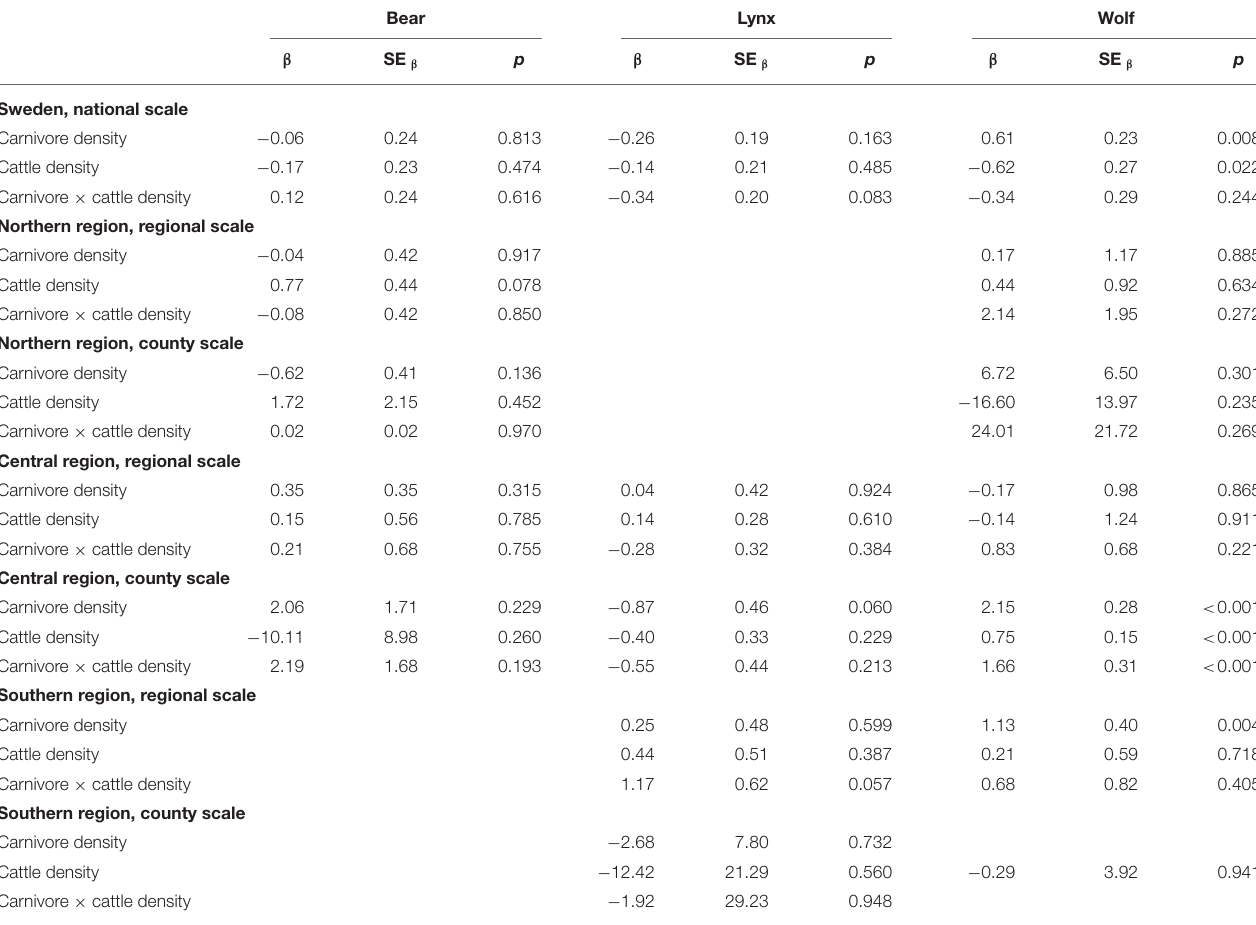
TABLE 1 | Beta coefficients describing the relationships between number of damaged cattle by brown bears, Eurasian lynx and gray wolves and densities of respective carnivore and cattle, as well interaction coefficients describing if the density of cattle influences the relationship between number of damaged cattle and densities of